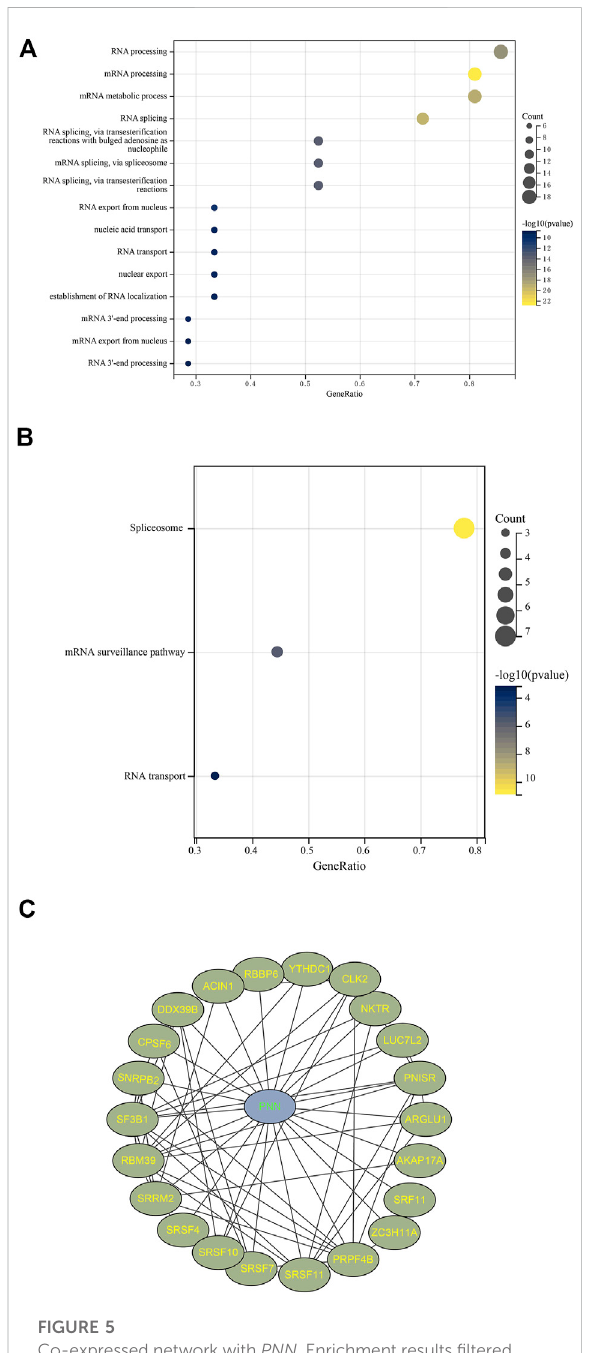
FIGURE 5 Co-expressed network with PNN . Enrichment results fi ltered with FDR < 0.05 based on 25 uniquely interacted and co- expressed genes with PNN with (A) GO and (B) KEGG. (C) Protein- Protein-interaction (PPI) network constructed using Cytoscape 3.8.2 based on PNN and